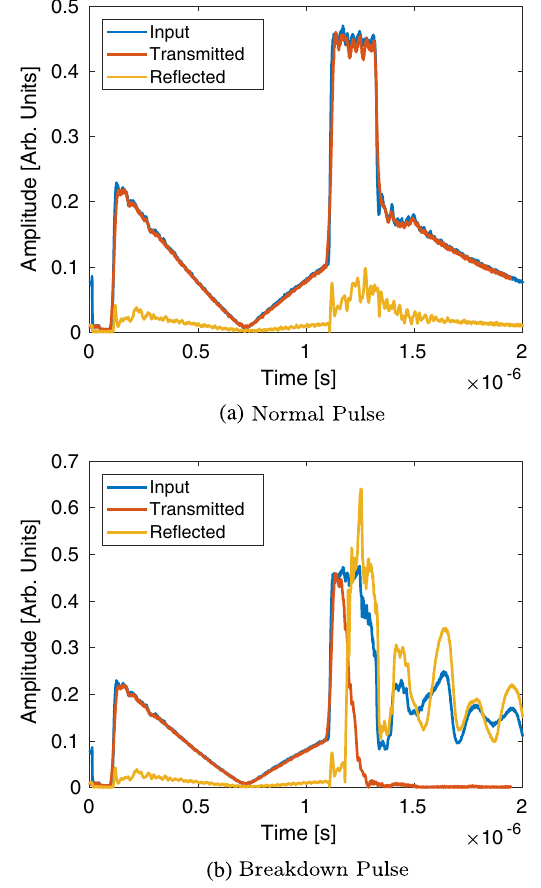
FIG. 11. Example of the rf signals for the input, transmitted, and reflected signals.